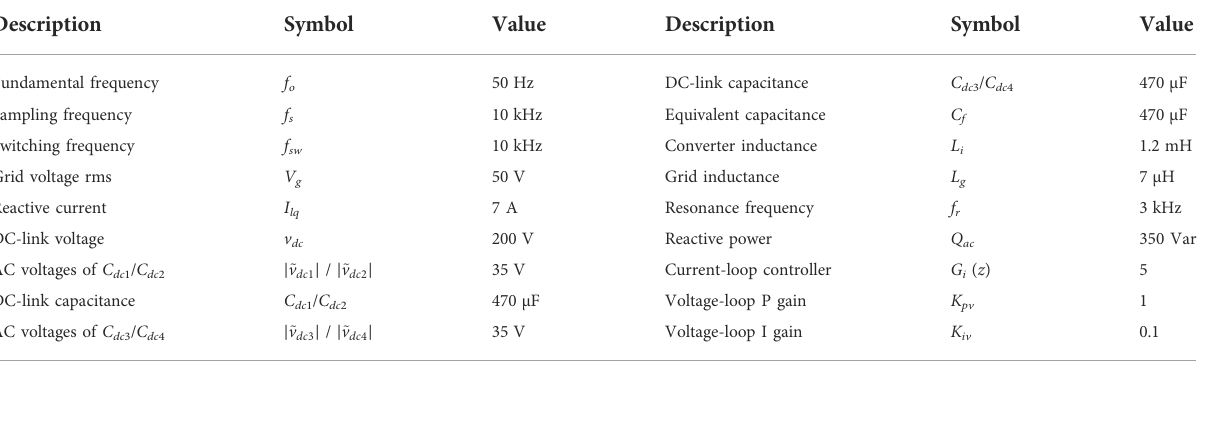
TABLE 1 System parameter values for the experiments.